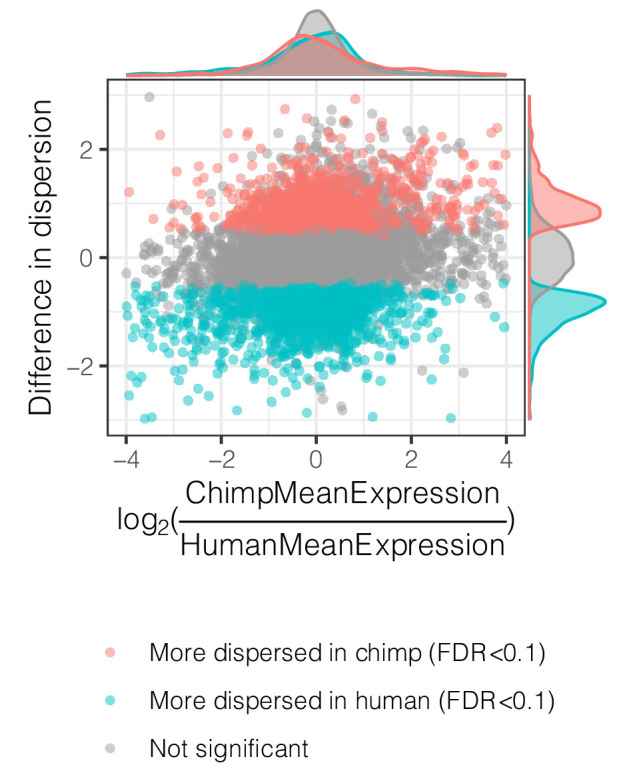
Interspecies dispersion estimates are largely independent from interspecies mean expression changes.Across all genes, the interspecies difference in dispersion, colored by significance, is plotted versus difference in mean expression.